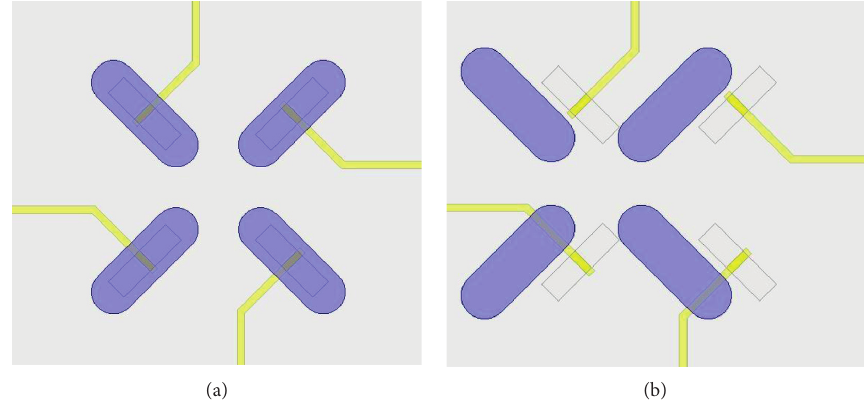
Figure 10: Different arrangements of slots and PCMs. (a) Overlapped. (b) Staggered.